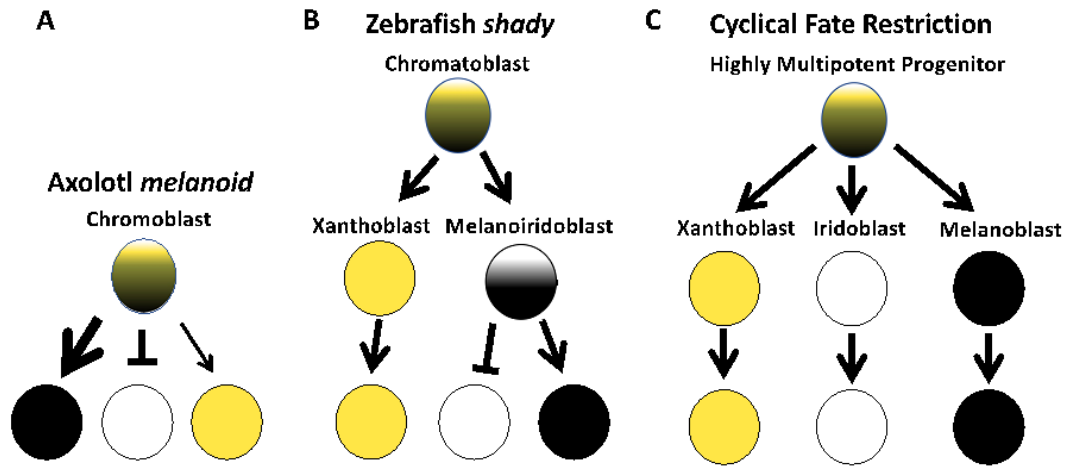
Figure 7. Models of pigment cell fate specification based on the results of this study and studies of zebrafish. ( A ) In axolotl, gene editing of Ltk affects iridophore and melanophore abundances, and proportionally fewer xanthophores are characteristic of melanoid . Arrows are weighted differently to show differences in pigment cell abundances. This model is consistent with direct fate specification of pigment cells from a multipotent progenitor. ( B ) In zebrafish shady , Ltk knockout only affects the specification of iridophores and does not affect melanophore or xanthophore abundances, consistent with progressive fate specification of iridophores and xanthophores [31]. ( C ) A cyclical fate restriction model recently proposed for zebrafish [15,16] posits dynamic, direct fate specification from highly multipotent progenitor cells. Yellow circles denote xanthophore lineage cells, white circles denote iridophore lineage cells, and black circles denote melanophore lineage cells.